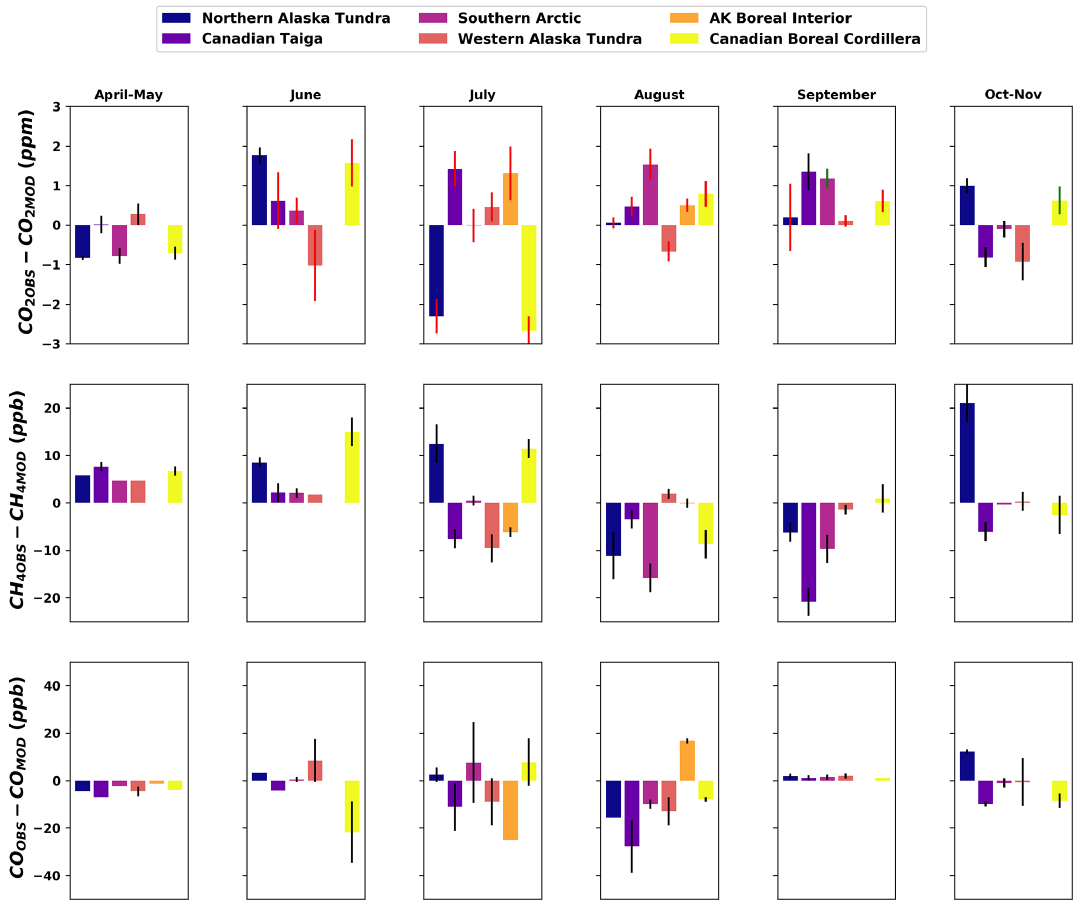
Figure 11. Average observation–model integrated enhancement differences by ecoregion. Standard deviation of differences for each region are shown with black and red bars. Red (black) bars signify a negative (positive) average enhancement below 3000m relative to the daily mean tropospheric value above 3000ma.s.l. for CO 2 and CH 4 and above 4000ma.s.l. for